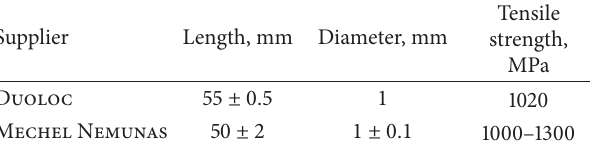
Table 2: Main parameters of the steel fibres.